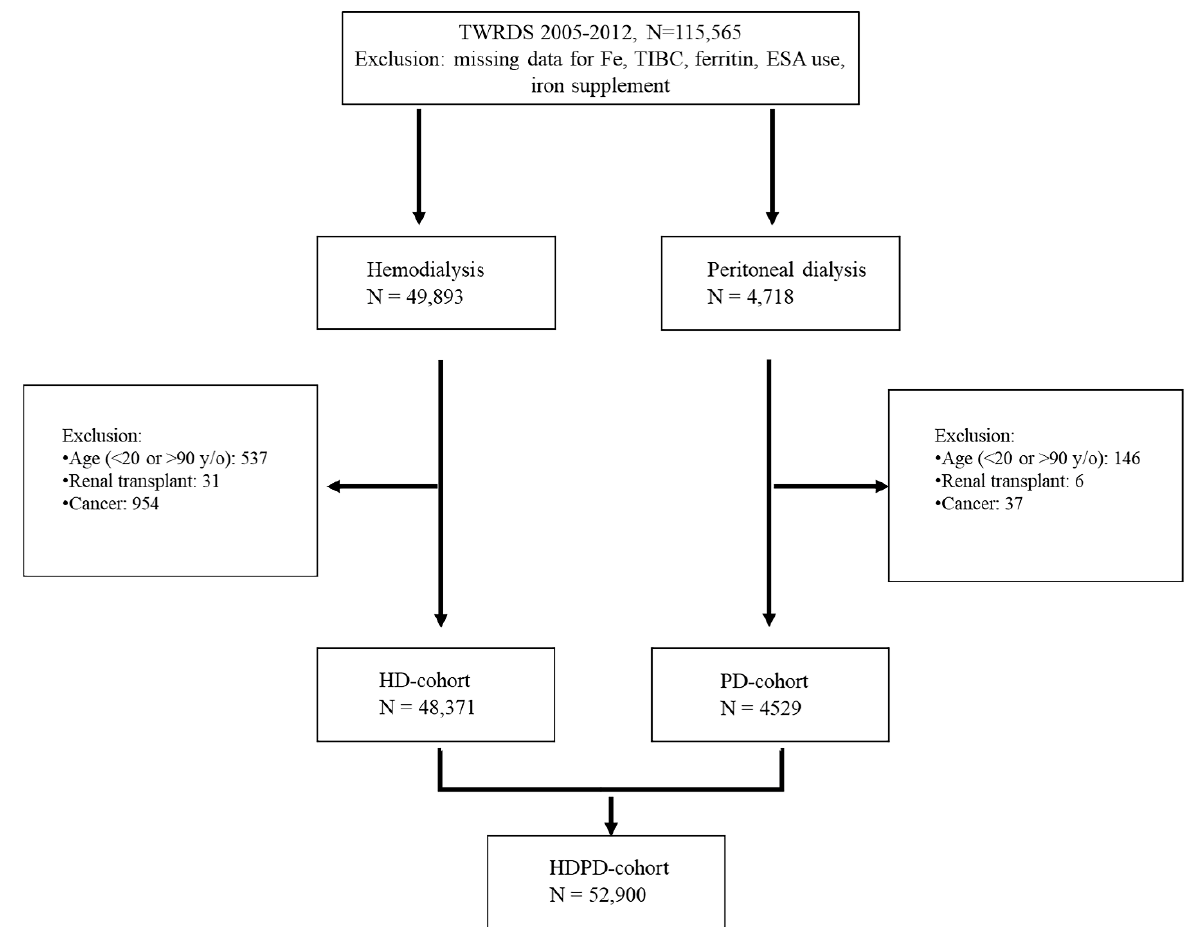
Figure 1. Flow chart of the whole population ( N = 52,900).